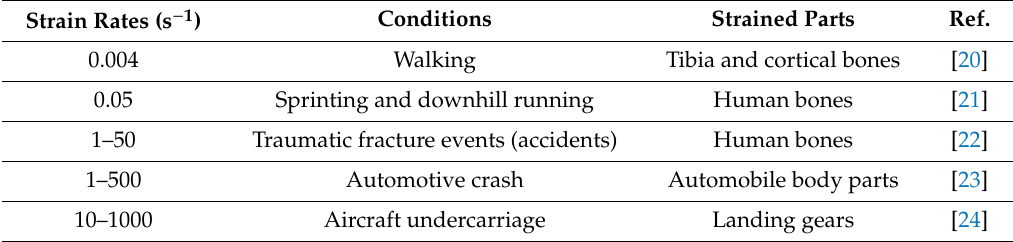
Table 1. Actual levels of strain rate in the human body, and structural parts under various conditions. Strain Rates (s − 1 ) Conditions Strained Parts Ref. 0.004 Walking Tibia and cortical bones [20] 0.05 Sprinting and downhill running Human bones [21] 1–50 Traumatic fracture events (accidents) Human bones [22] 1–500 Automotive crash Automobile body parts [23] 10–1000 Aircraft undercarriage Landing gears [24]